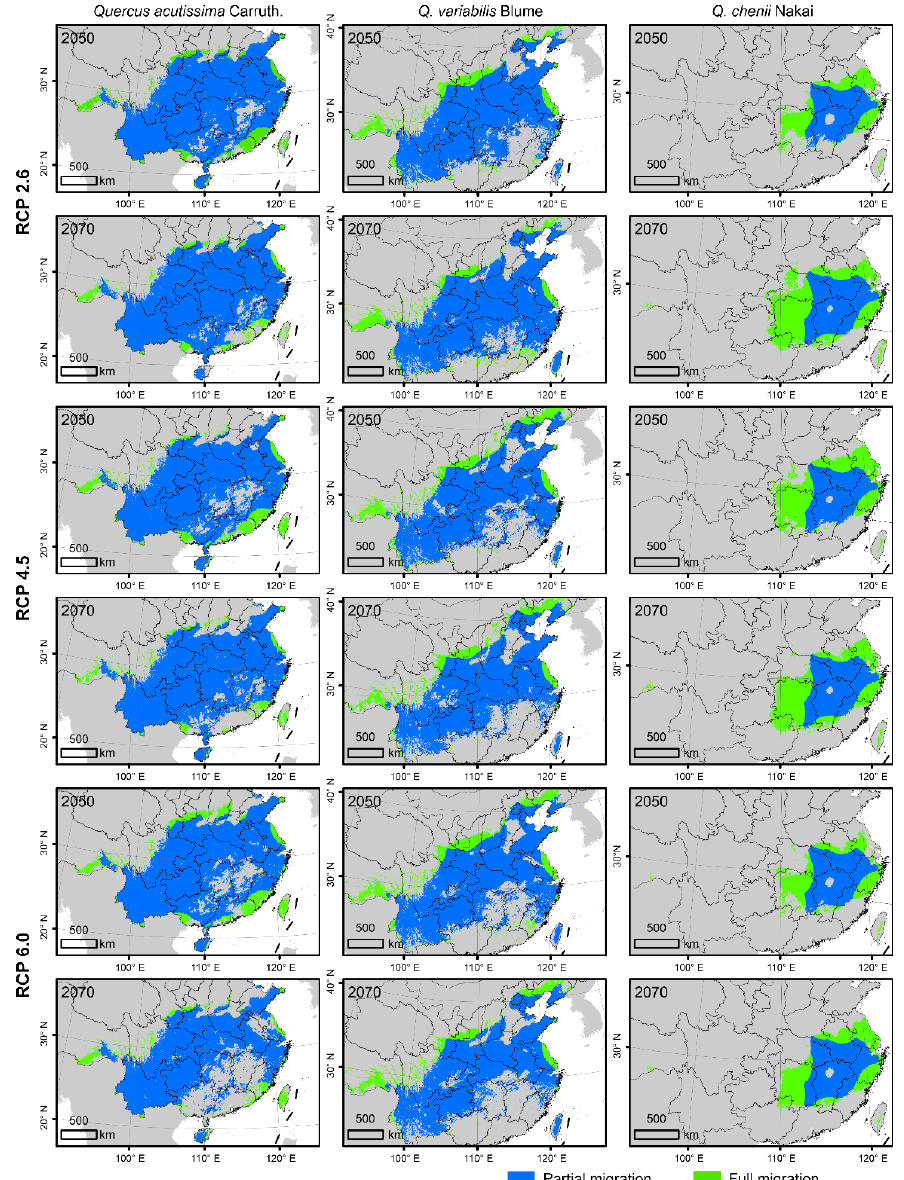
Figure 4. Future suitable habitats of the three East Asian Cerris oaks in China in the years 2050 and 2070 under three representative concentration pathways (RCPs), i.e., RCP 2.6, RCP 4.5, and RCP 6.0. They were predicted by species distributions models (SDMs) considering climate change (CC), land use and land cover change (LULC) and dispersal limitations. The green and blue areas represent the suitable habitats under the full migration (FM, i.e., migration unlimited) and partial migration (PM, 500 m/year) scenarios, respectively. The species-specific maximum training sensitivity plus specificity (MTSS) thresholds were used to classify the suitable habitats (>MTSS) and unsuitable habitats (<MTSS).